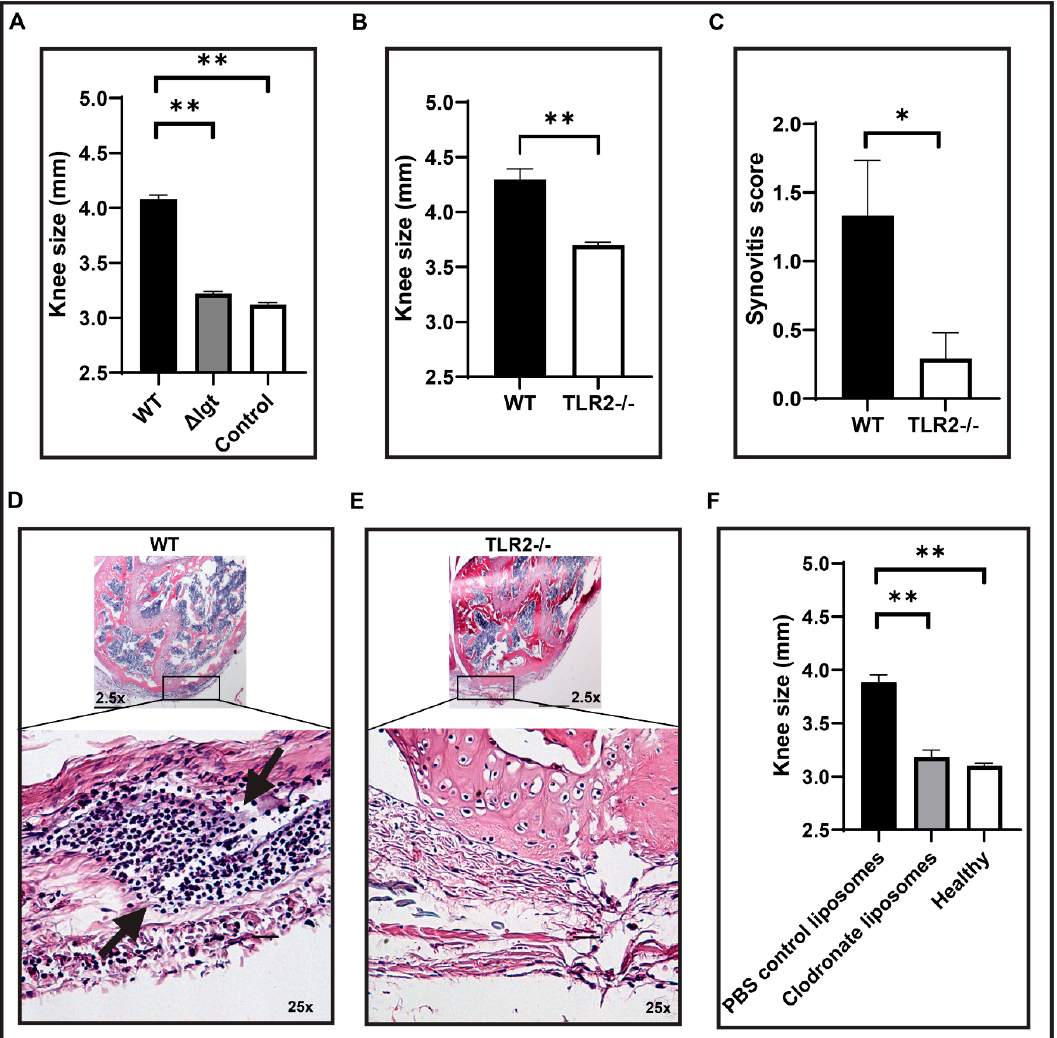
Figure 5. Lipoproteins in S. aureus EVs induce inflammation through monocytes/macrophages via TLR2 in mice. Size of the knee joints of the mice intra-articularly injected with S. aureus wild-type (WT) Newman and Newman Δ lgt strain EVs ( A ). Knee scale of the C57Bl/6 wild-type (WT) and toll-like receptor knockout (TLR2 − / − ) mice intra-articularly injected with S. aureus Newman EVs ( B ). Inflammation score of the synovitis tissue ( C ) and representative images of hematoxylin and eosin staining of knee joints of WT ( D ) and TLR2 − / − ( E ) mice. Knee scale of NMRI mice treated with Clodronate liposomes and PBS control liposomes intra-articularly injected with S. aureus Newman EVs ( F ). Statistical analyses were performed using the Mann–Whitney U test and the data represented as the mean with SEM. * p < 0.05; ** p < 0.01. Arrows in D indicate leukocyte